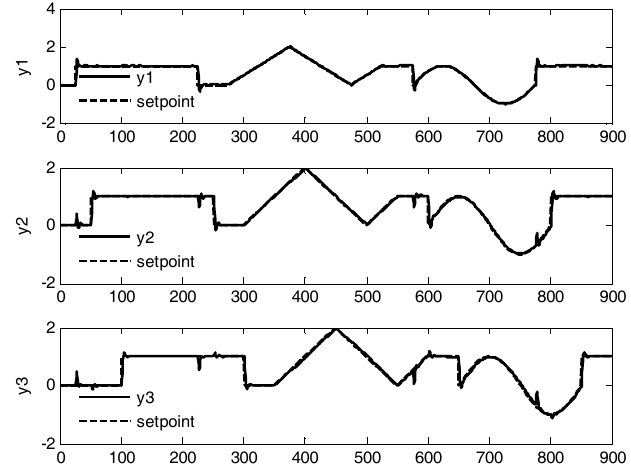
Figure 10. Control results of offset free MPC in dynamic PLS.